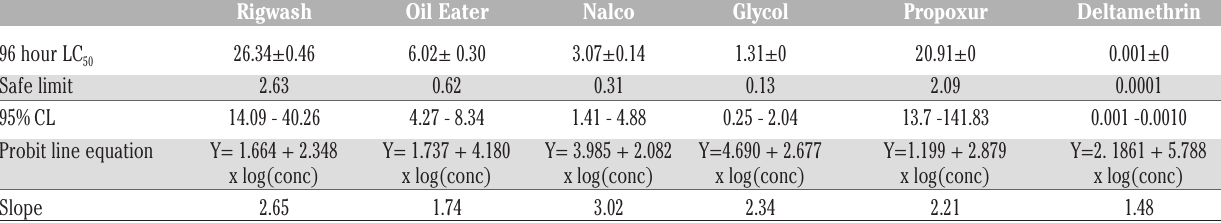
Table 1. Acute toxicity profile of fish ( Tilapia guineensis ) exposed to the test chemicals at 96 hours. Rigwash